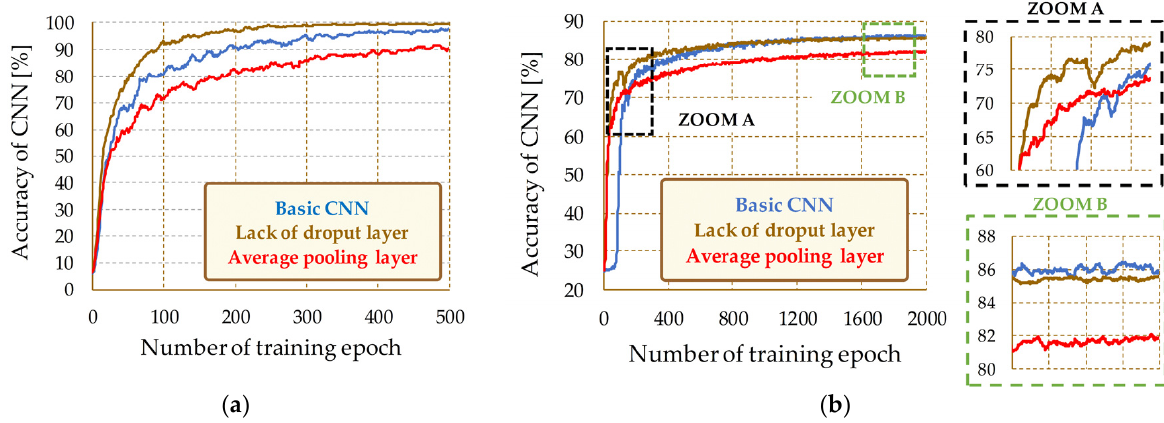
Figure 10 . Influence of the PL and DROP layers on the precision of the CNN network—learning curves: ( a ) IM; ( b ) PMSM.